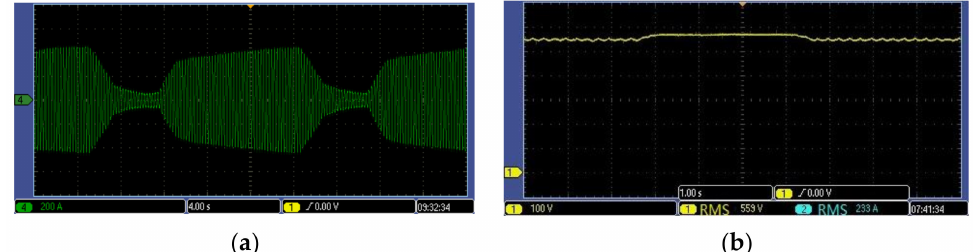
Figure 14. Experimental results in the faulty operation without reconstructing topology. ( a ) the output currents; ( b ) the DC side voltage.